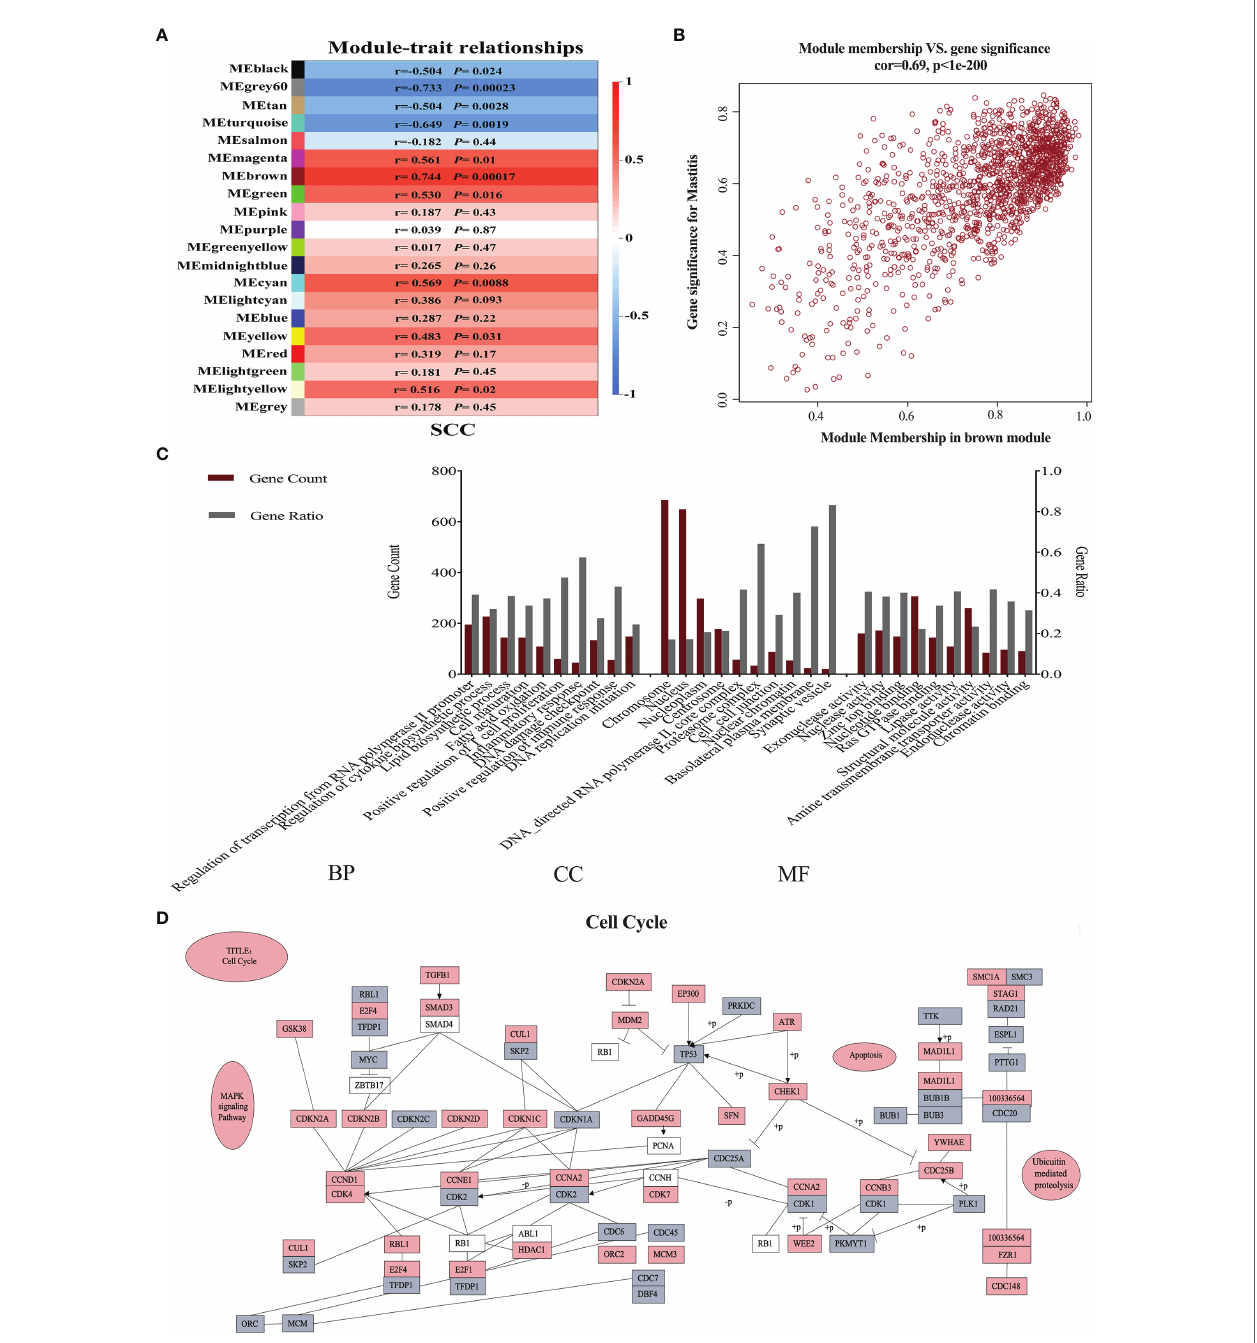
FIGURE 1 | Neutrophil weighted gene coexpression network analysis in dairy cows with low and high somatic cell counts (SCCs) at Week 1 pre- and postpartum. (A) The relationship between coexpressed modules and SCCs. (B) Gene distribution map in the brown module is shown in brown in (A) . (C) Gene ontology analysis of hub genes in the brown module. (D) The hub genes involved in the cell cycle. Gray indicates downregulated genes, and red represents upregulated genes. BP, biological process; CC, cellular component; MF, molecular